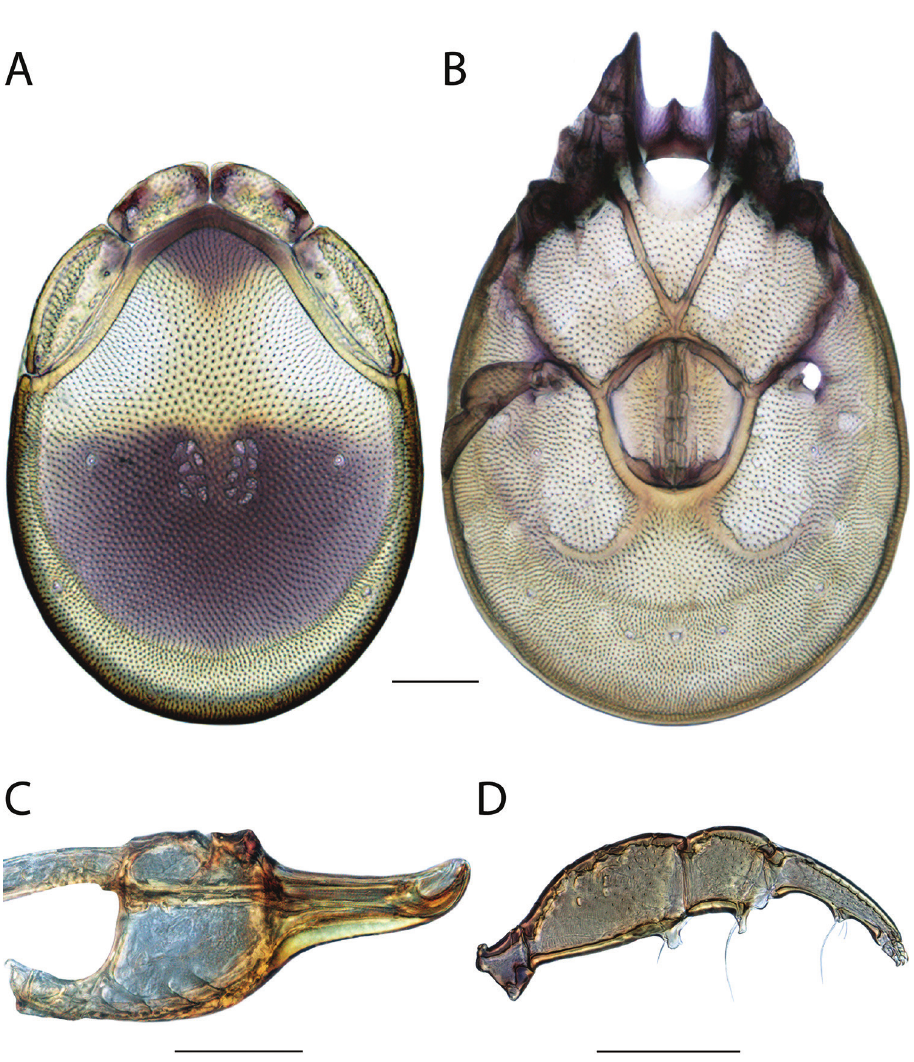
Figure 33. Torrenticola bondi sp. n. female: A dorsal plates B venter (legs removed) C subcapitulum D pedipalp (setae not accurately depicted). Scale = 100